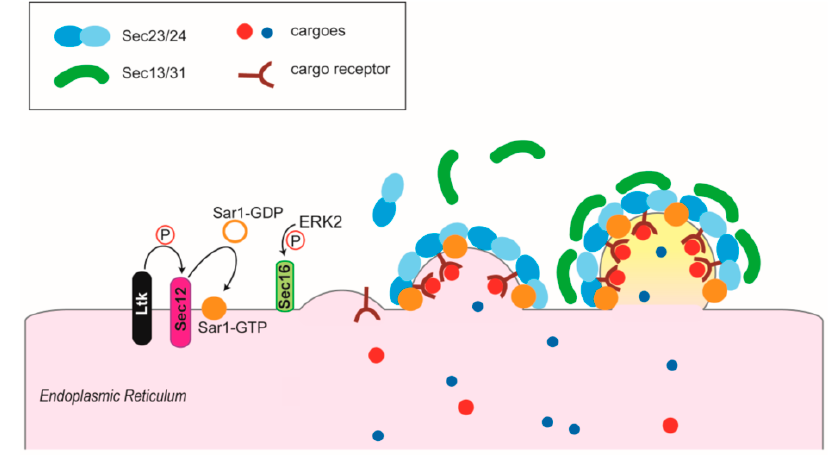
Figure 3. COPII assembly. The assembly of COPII vesicles is started by the activity of Sec12, which works as a nucleotide exchange factor for Sar1-GDP. Sar1-GTP is able to insert into the membrane of the ER at the ERES, recruiting first the Sec23 / Sec24 heterodimer. The vesicle is completed with the addition of Sec13 / Sec31. Cargo receptors or transmembrane cargoes can directly interact with Sec23 / sec24 components. Sec12 can be activated by LTK. Sec16, another molecule part of the COPII coat, can be phosphorylated and hence activated by